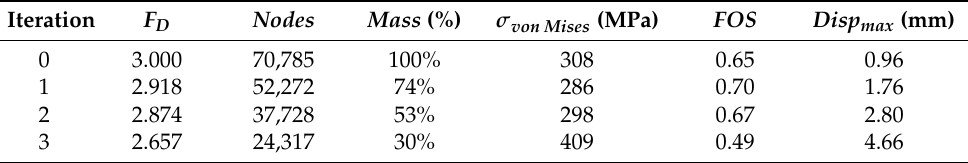
Table 1. Fractal dimension of the set of beams based on the Menger